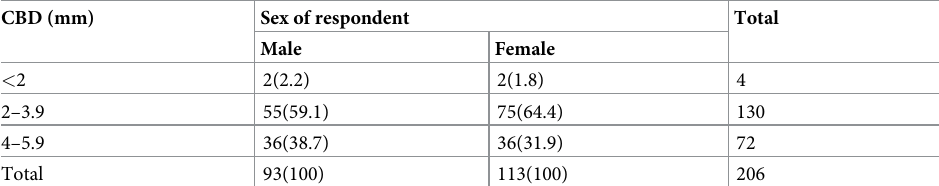
Table 2. Diameter of CBD stratified by sex, Northwest Ethiopia,